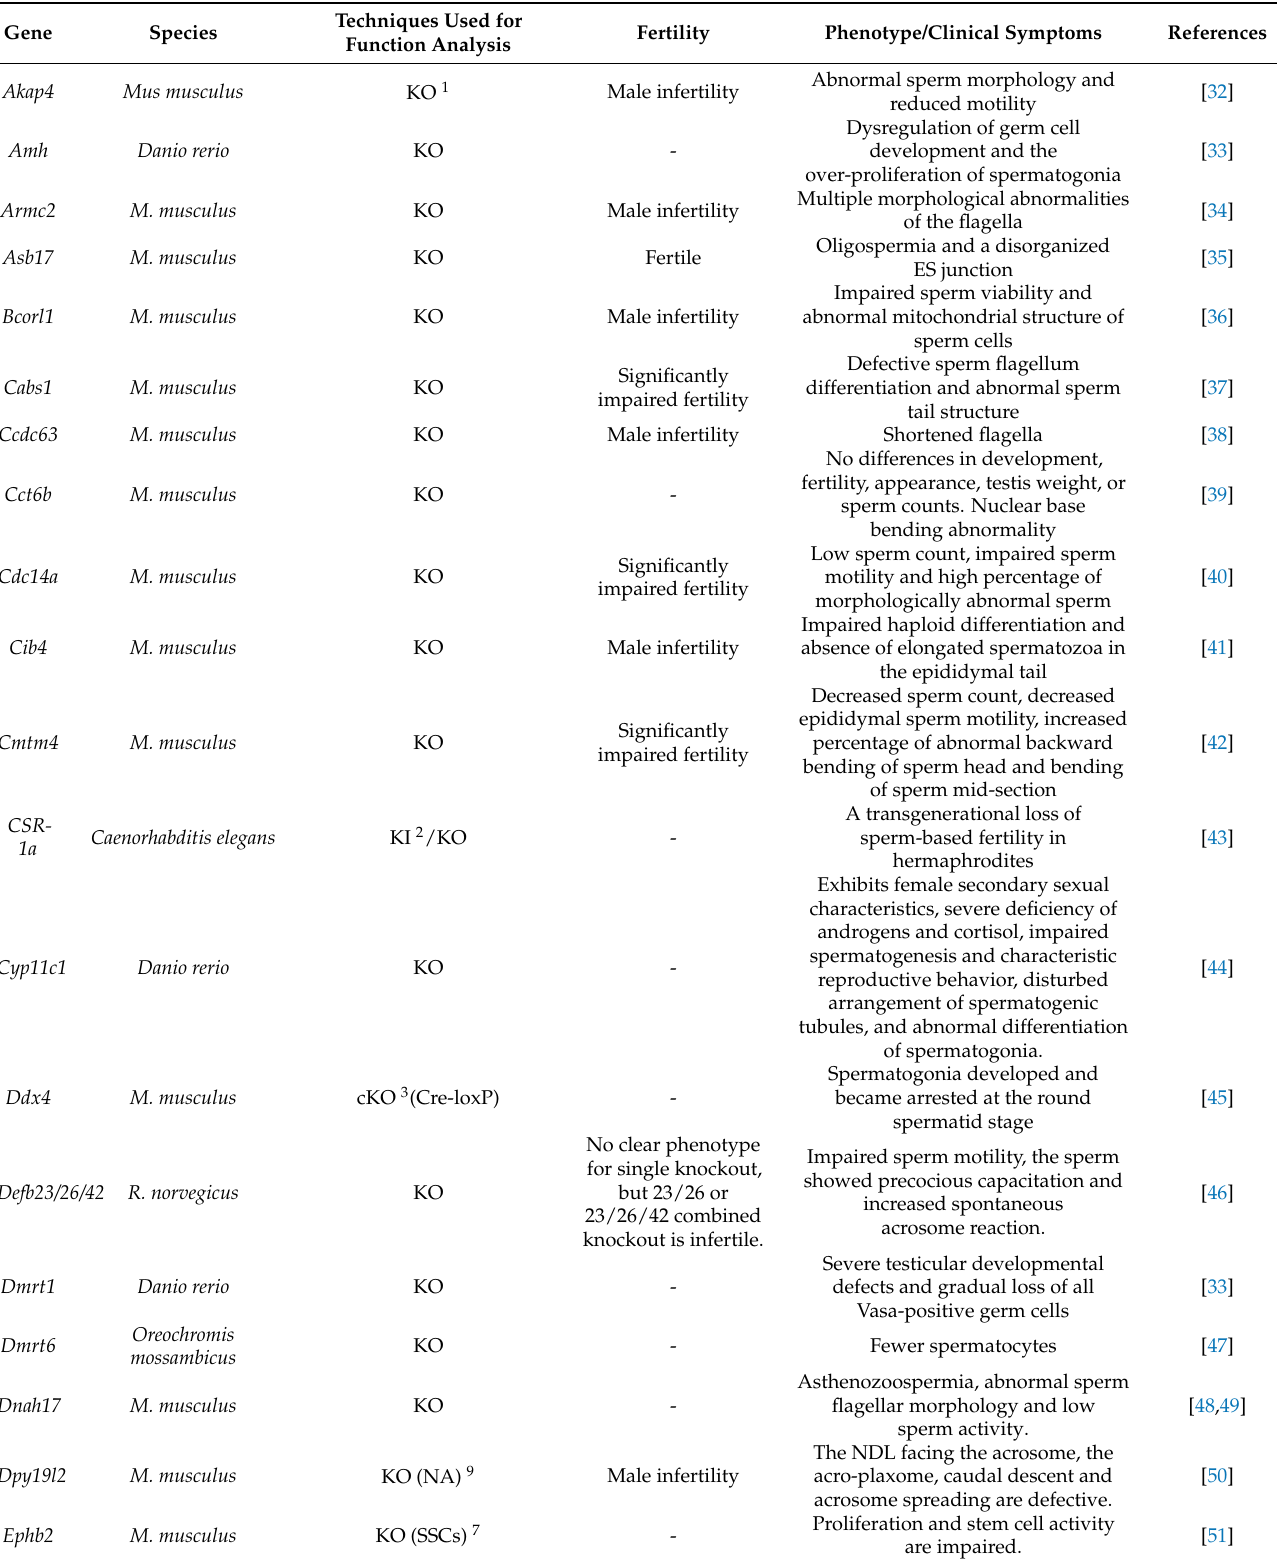
Table 1. Genes related to spermatogenesis unearthed by gene editing